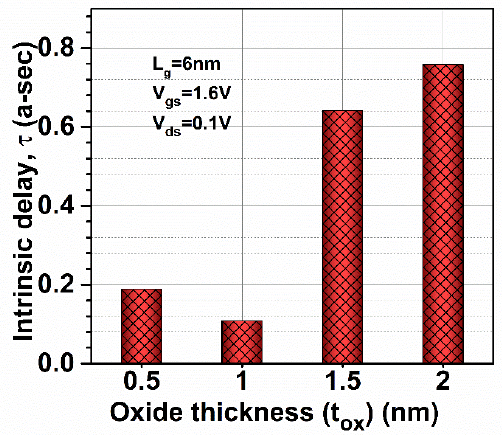
Figure 18. Intrinsic delay at various oxide thicknesses of GaN-SOI-FinFET.